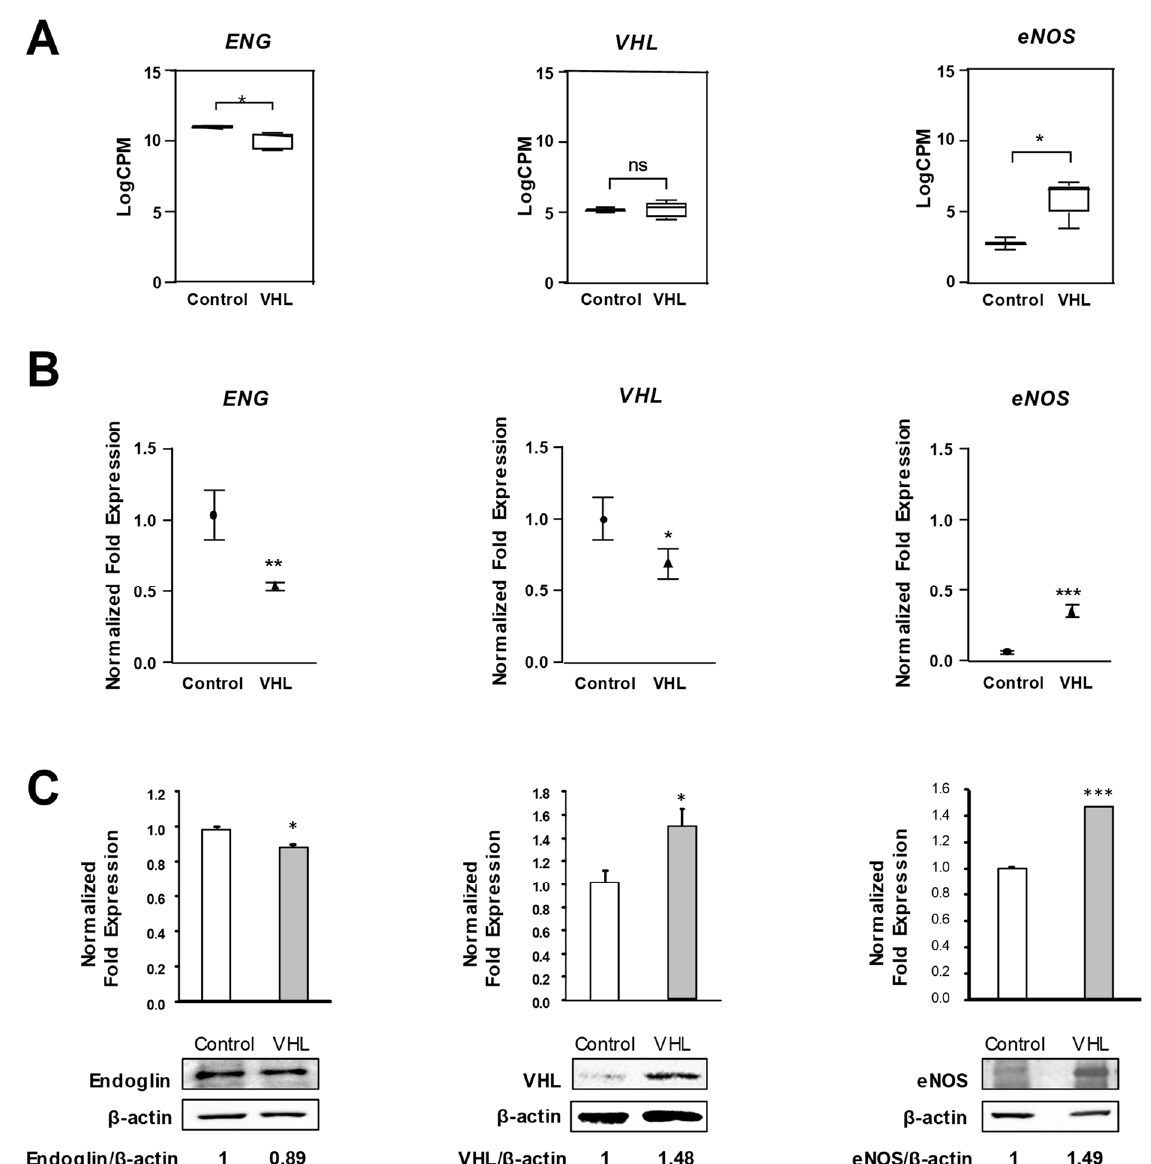
Figure 3. RNAseq validation for Endoglin , VHL, and eNOS . ( A ) RNAseq results derived of primary cultures of ECs from control ( n = 2) and VHL patients ( n = 5). ( B ) qPCR results of Endoglin , VHL, and eNOS from different controls ( n = 2) and VHL ECs ( n = 3). ( C ) Western-blot analysis of Endoglin, VHL, and eNOS protein levels from primary ECs, normalized to β -actin. Densitometric quantification of Endoglin/ β -actin, VHL/ β -actin, and eNOS/ β -actin ratios are shown. Results shown are representative of three different experiments. Error bars denote ± SEM. Student’s t -test: * p < 0.05; ** p < 0.01; and *** p < 0.001.